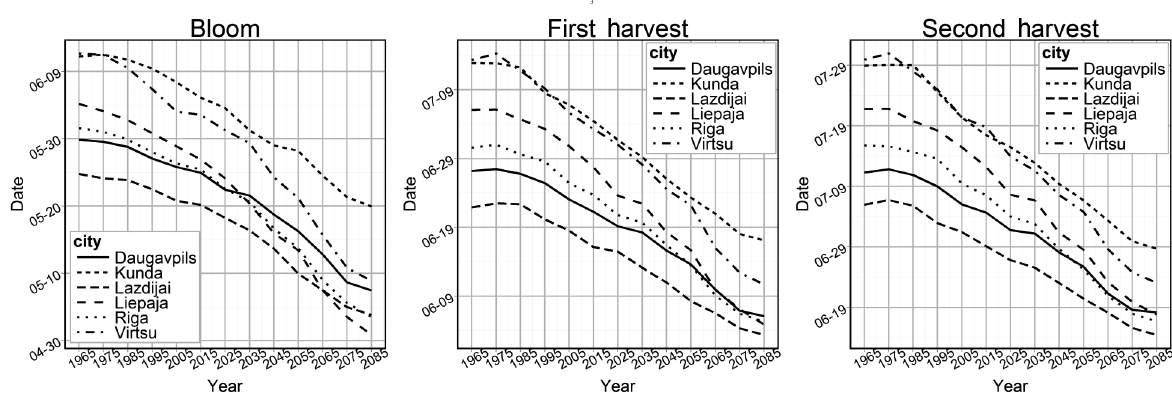
Fig. 8. Comparison of time series between locations shown in Fig. 7 for each phenological process. Lines show ensemble median.